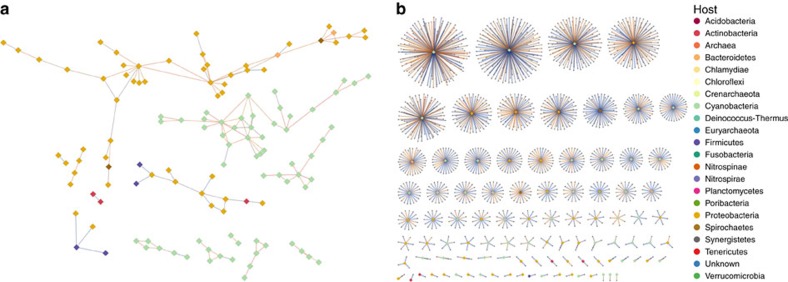
Viral co-occurrence networks.The large diamonds represent the reference viral genomes colour coded according to the host phylum, and the small grey diamonds represent the MVCs. The line colours follow a gradient according to SparCC score from blue (0.6) to red (0.9). (a) The network displaying the strongest correlations with a SparCC score >+0.6 between reference phage genomes only. (b) The network displaying the strongest correlations with a SparCC score >+0.6 between MVCs and reference phage genomes.